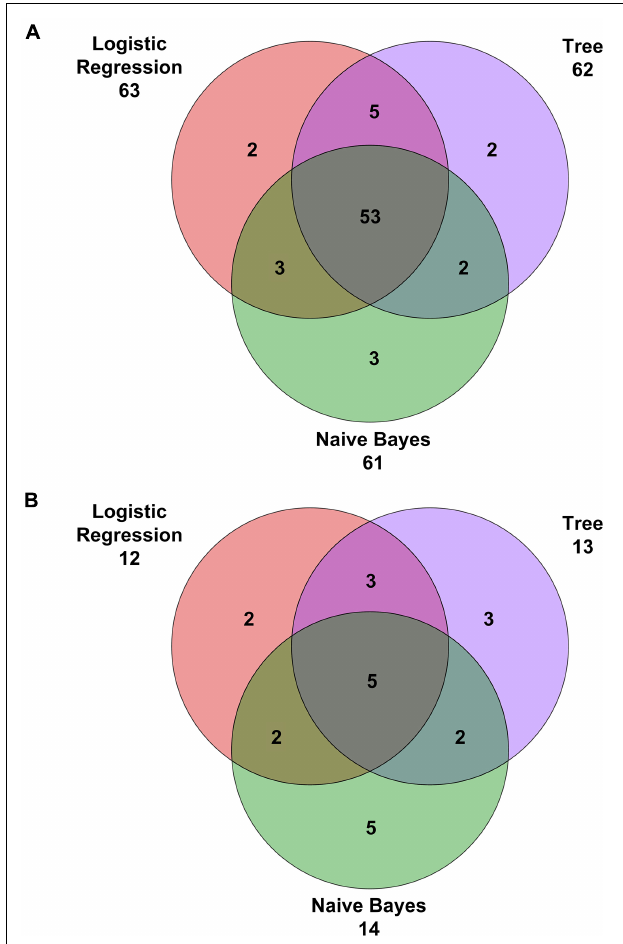
FIGURE 5 | Venn diagrams with (A) correct classifications and (B)